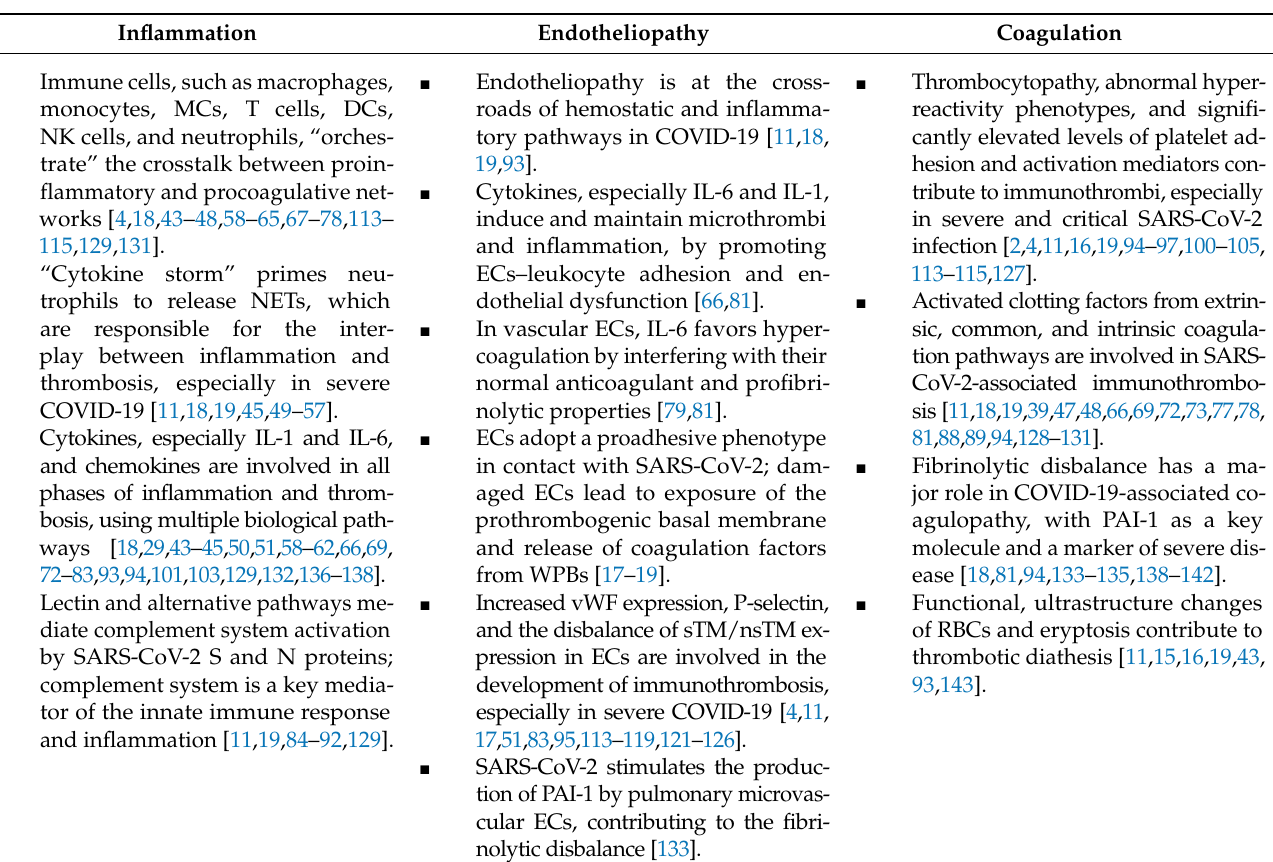
Table 1. Biological pathways of COVID-19 associated immunothrombosis. Inflammation